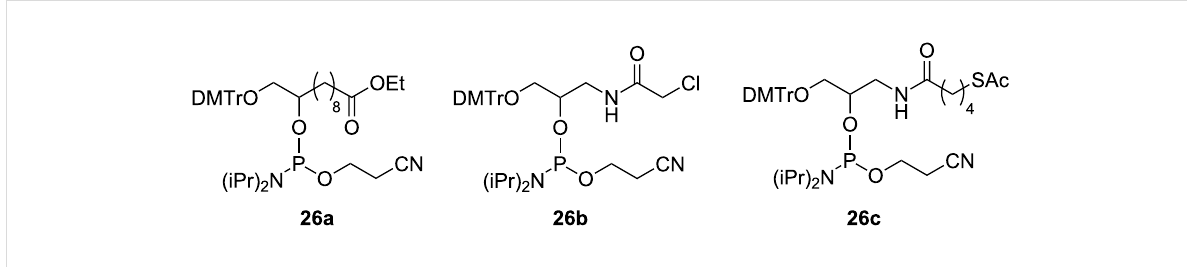
Figure 2: Structure of phosphoramidites containing electrophilic groups.